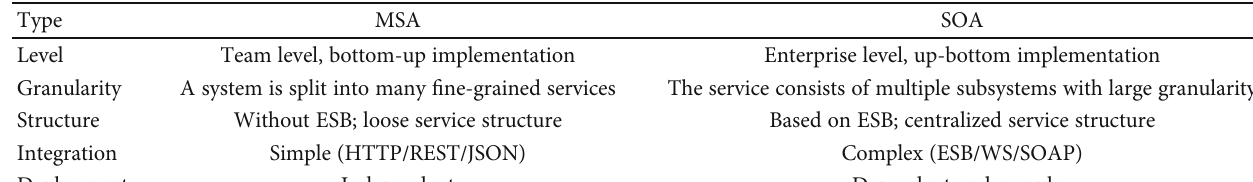
Table 1: Comparison between MSA and SOA.